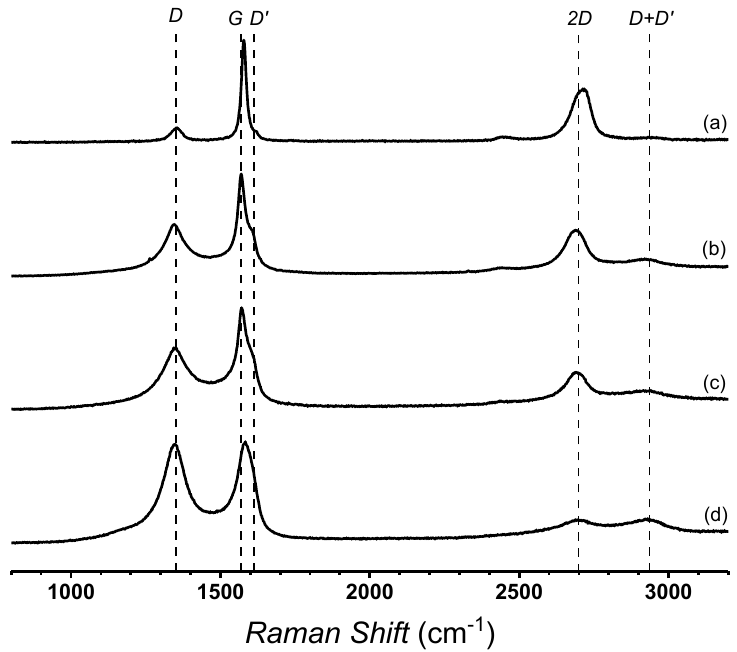
Figure 2. Raman spectra of graphite ( a ), GO ( b ), TRGO 600 ( c ), and TRGO 1000 ( d ). Table 2. Structural features of graphite, GO, TRGO 600 , and TRGO 1000 determined by X-ray diffraction and Raman spectroscopy.